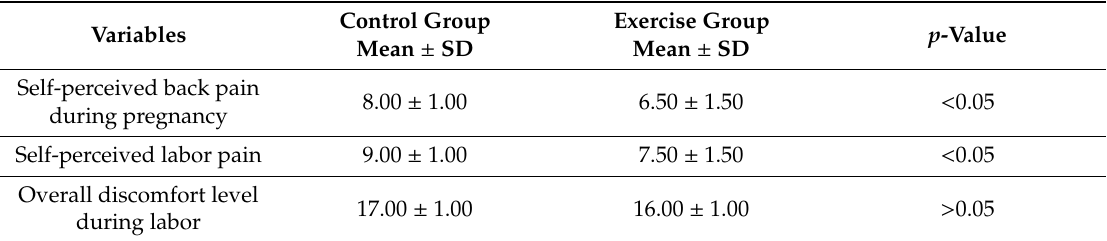
Table 5. Score of back pain (VAS) during pregnancy, labor pain (VAS), and overall discomfort level (adapted Borg scale) during labor in the control ( n = 75) and experimental ( n = 75)